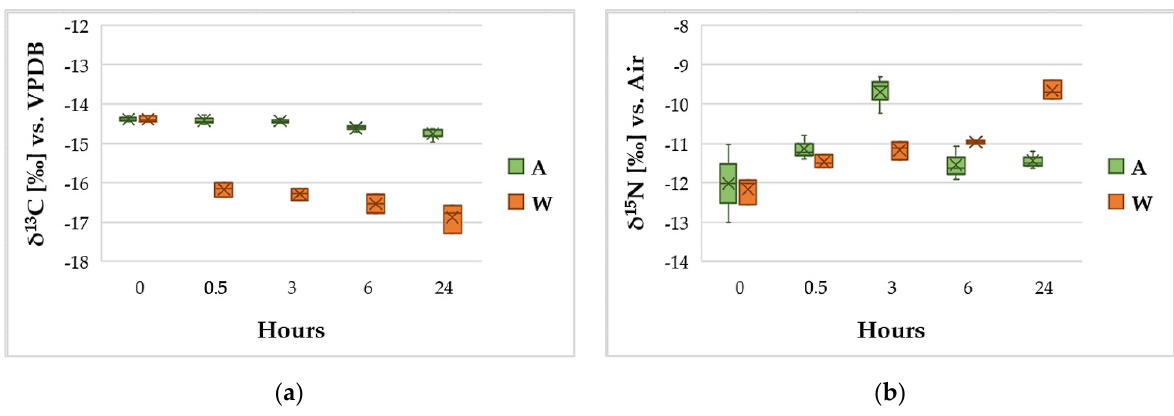
Figure 6. Variation of δ 13 C ( a ) and δ 15 N ( b ) in the biomass grown in wastewater (W) and Allen medium (A).